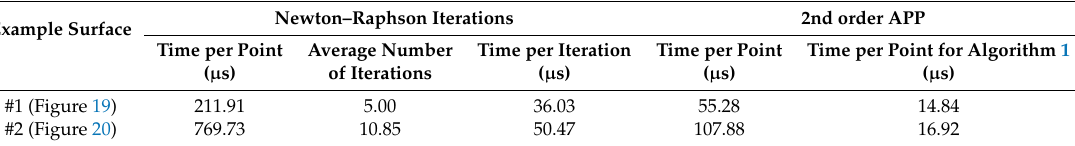
Table 4. The results of point projection for NURBS surfaces. The tolerance in Newton–Raphson iterations was chosen as (cid:101) = 10 − 8 . Note that the time of finding an initial point is excluded in the time per